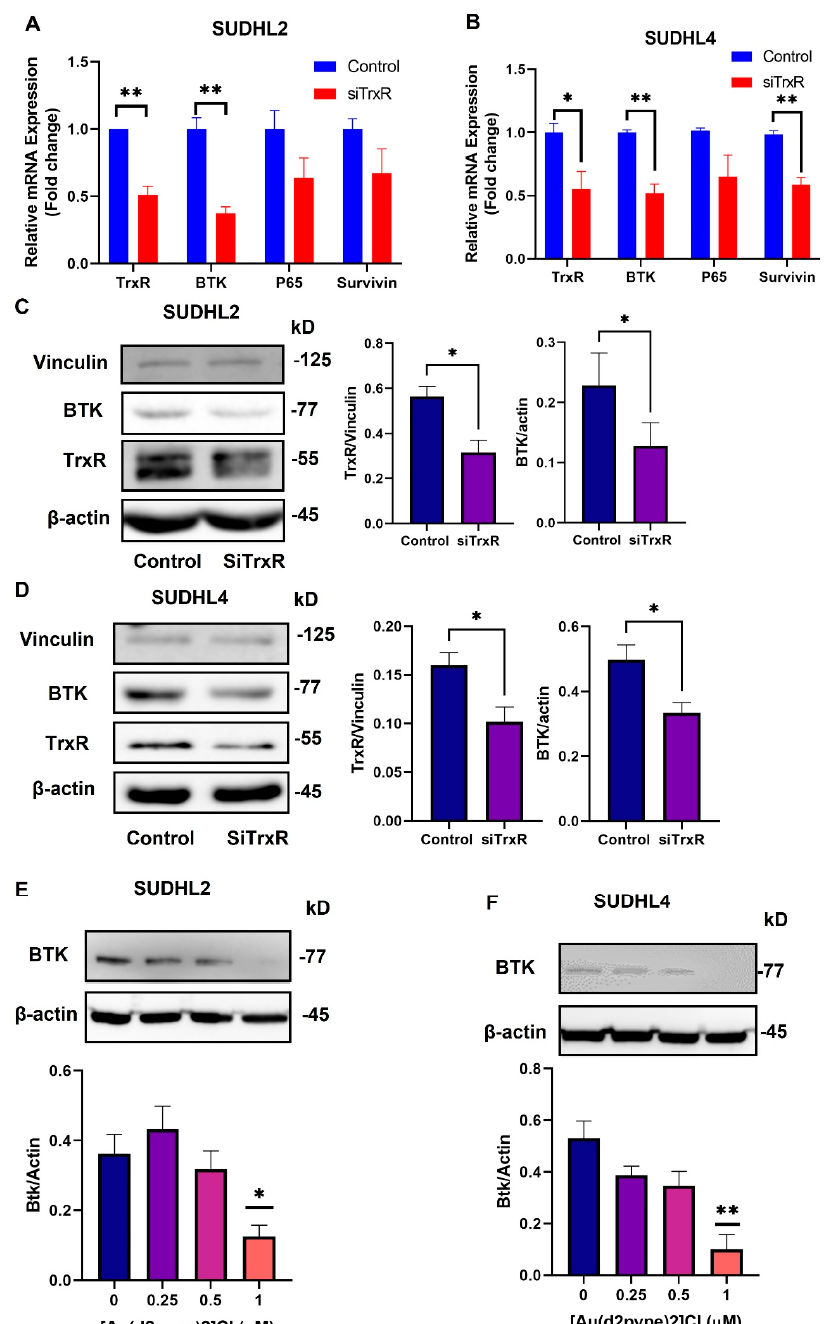
Figure 3. TrxR1 knockdown decreases BCR/NF- κ B pathway-related mRNA and protein expression. SUDHL2 and SUDHL4 cells were transfected with TrxR1 specific siRNA (siTrxR) and a scrambled siRNA (control). ( A , B ), RT-qPCR was performed 48 h after transfection to determine the mRNA expression of TrxR1, BTK, p65, and surviving in SUDHL2 and SUDHL4 cells. ( C , D ), Western blotting was performed 48 h after transfection to determine the protein levels of BTK and TrxR in SUDHL2 and SUDHL4 cells. ( E , F ), The BTK expression was detected after treating cells with the indicated [Au(d2pype) 2 ]Cl after 24 h in SUDHL2 and SUDHL4 cells. B-actin was used as the loading control for BTK protein blots, and Vinculin was used as the loading control for the TrxR protein blots. Western blots are representative of 3 independent experiments. Significance levels are marked as * p < 0.05 and ** p < 0.005.